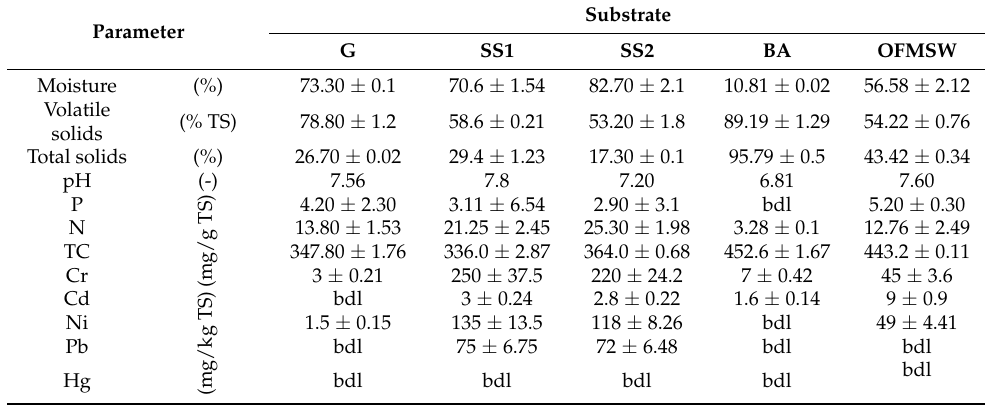
Table 2. Characteristics of raw materials.